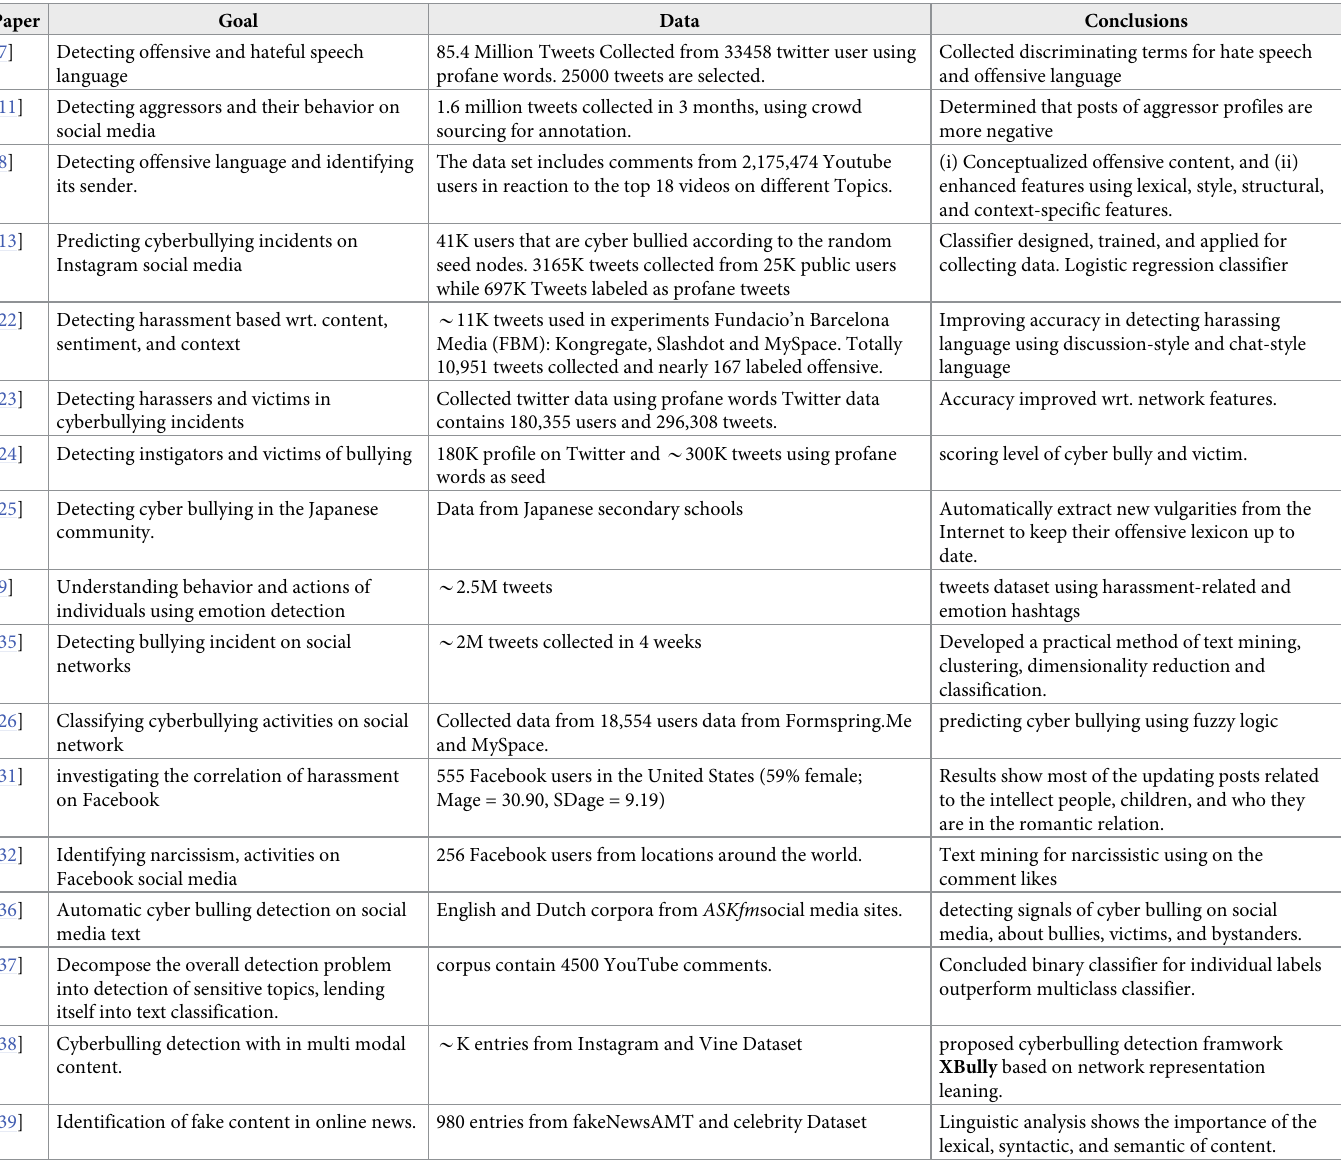
Table 1. Summery of the related